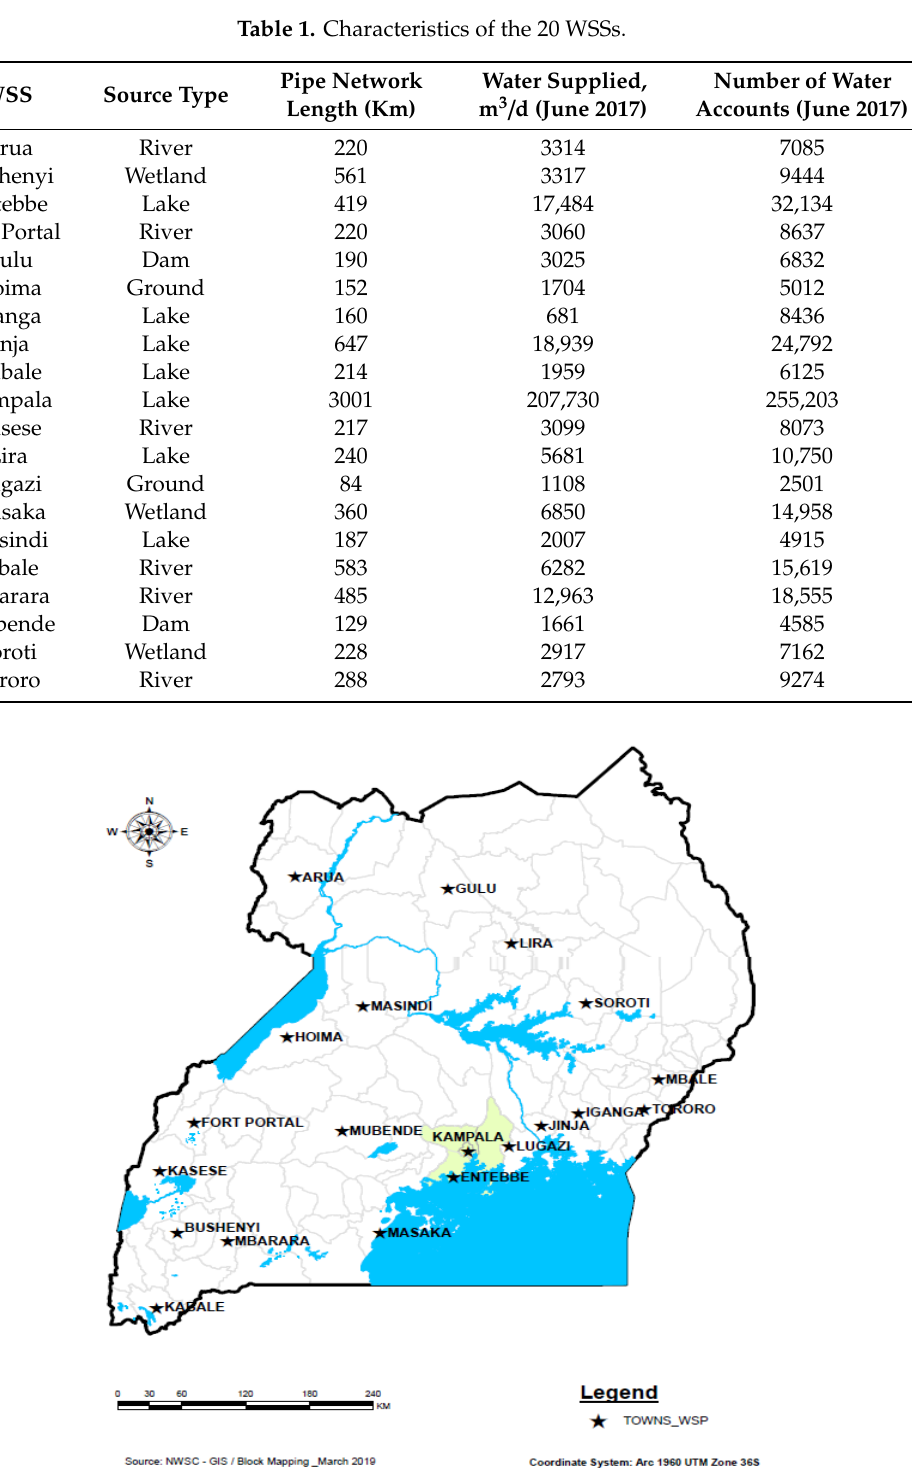
Figure 1. Location of the 20 Water Supply Systems (WSSs) managed by the National Water and Sewerage Corporation (NWSC) and implementing Water Safety Plans (WSPs). Table 1. Characteristics of the 20 WSSs.